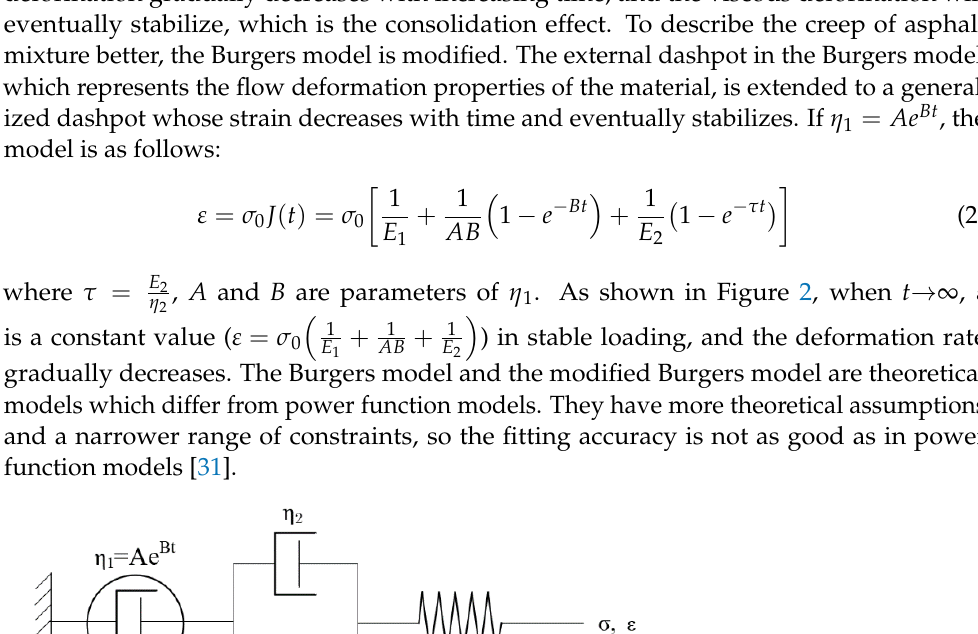
Figure 1. Burgers model with four units and four parameters.